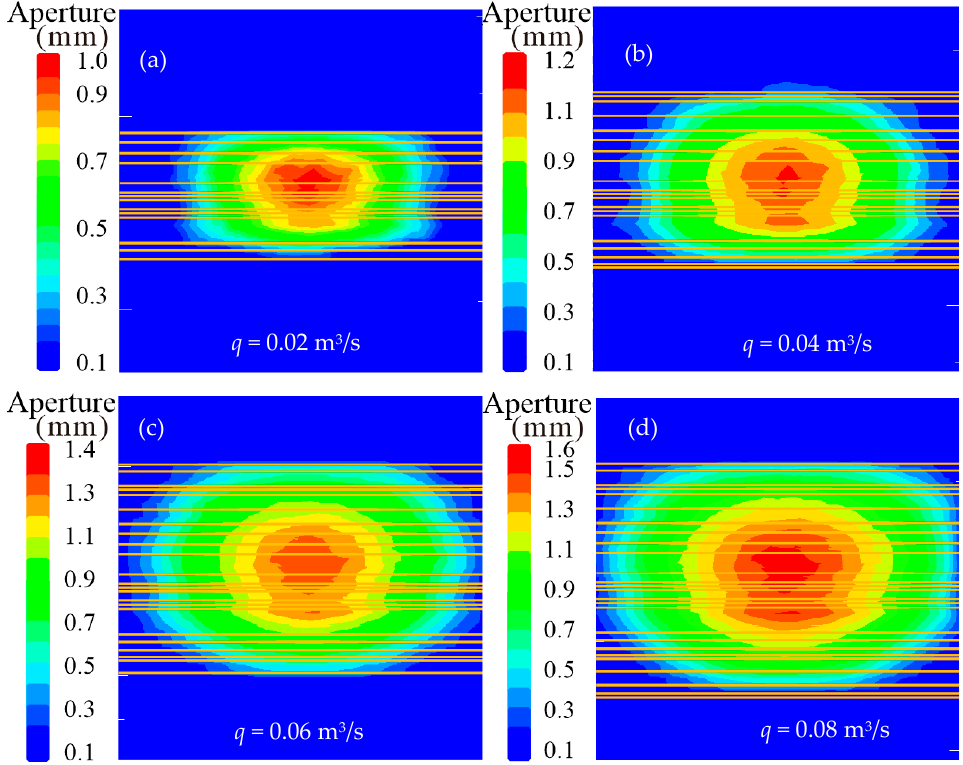
Figure 12. Fracture geometry and aperture distribution in different cases, with the injection rate of